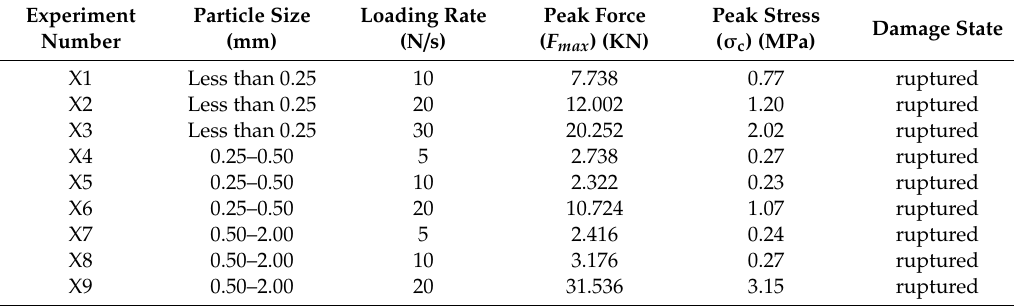
Table 2. Experimental scheme and damage of shaped coal specimens.